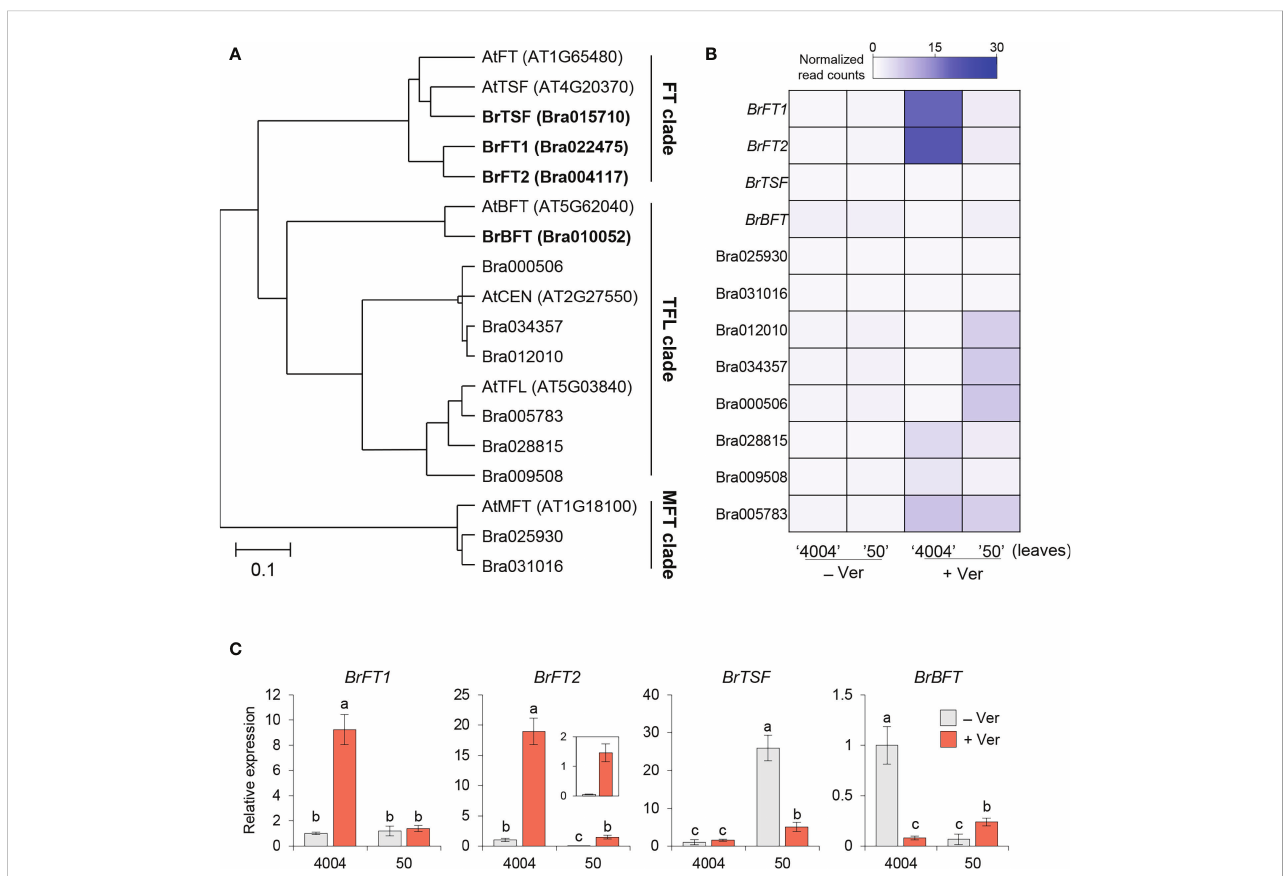
FIGURE 1 Identi fi cation of FT-like proteins from PEBP candidates in Chinese cabbage ( Brassica rapa subsp. pekinensis ). (A) Phylogenetic tree of PEBP members from Arabidopsis and Chinese cabbage. The tree was constructed using Bayesian evolutionary analysis in BEAST 2.5 (version 2.7.1). The scale bar represents the 95% highest posterior density (HPD) interval for the age of each node in the tree. PEBPs cluster into three clades. (B) Heatmap representation of the expression levels of Bra PEBP candidates based on RNA-seq analysis in Chinese cabbage. Columns represent the two Chinese cabbage inbred lines (4004; early bolting, 50; late bolting) exposed (+, for 35 days) or not ( – ) to vernalization treatment. RNA-seq was performed using the leaf samples of Chinese cabbage with or without vernalization. Normalized read counts were calculated from the mean of three biological replicates. (C) RT-qPCR analysis of BrFT-like gene expression in the two inbred lines 4004 and 50. BrActin 2 ( BrACT2 ) was used for normalization. For each gene, the expression level in non-vernalized 4004 was set to 1. Data are means ± SE of three biological replicates. Different lowercase letters represent signi fi cant differences, as determined by one-way ANOVA followed by Tukey ’ s post-hoc test ( P <